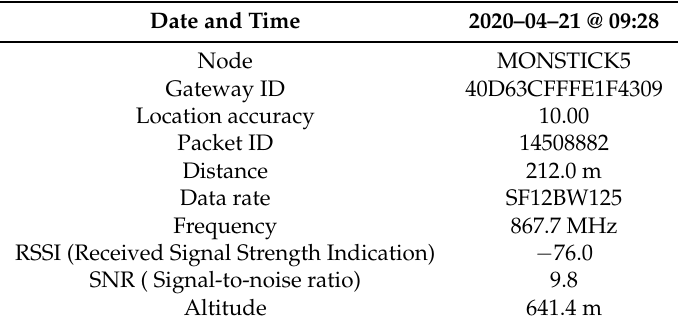
Table 4. Example of measurement record using TTN mapper.